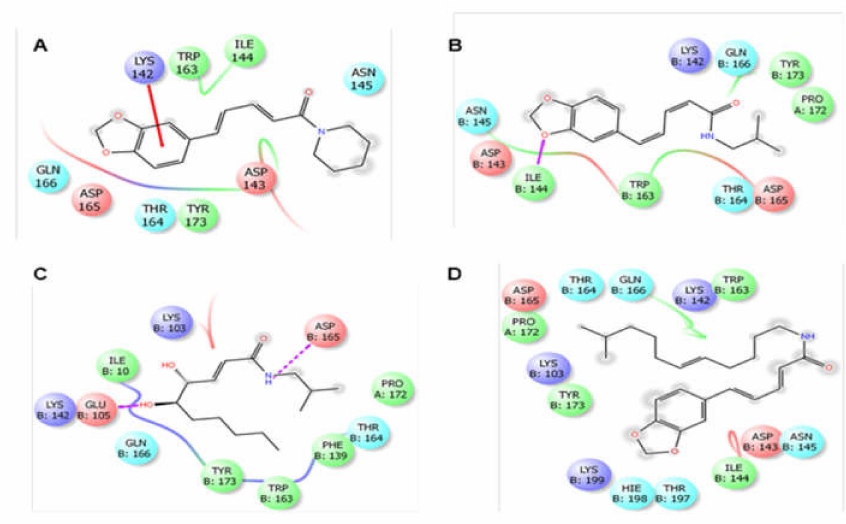
Figure 5. 2D interactions of the piperine ( A ), piperlonguminine ( B ), sylvamide ( C ), and sylvatine ( D ) with the active site of potassium channel (PDB: 4UUJ).